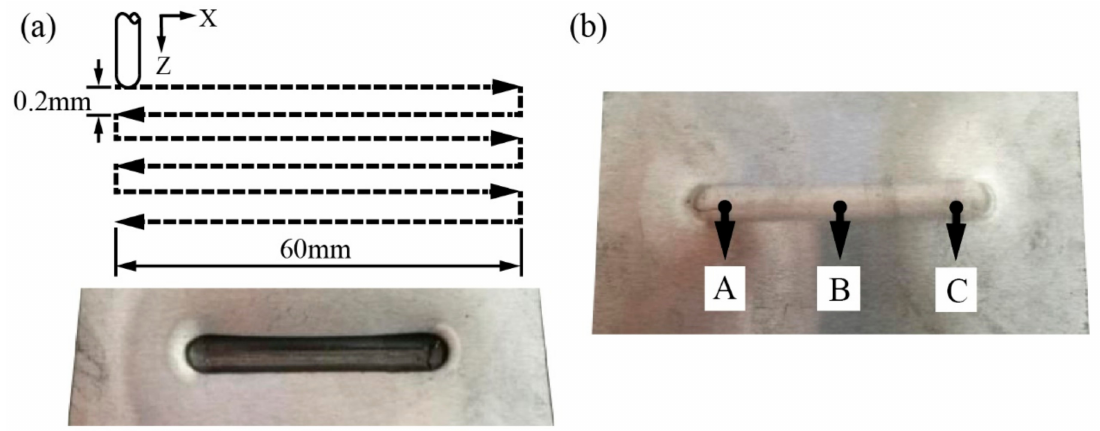
Figure 3. ( a ) Schematic diagram of the tool path for forming a straight groove and ( b ) sampling points A, B and C on the back of the